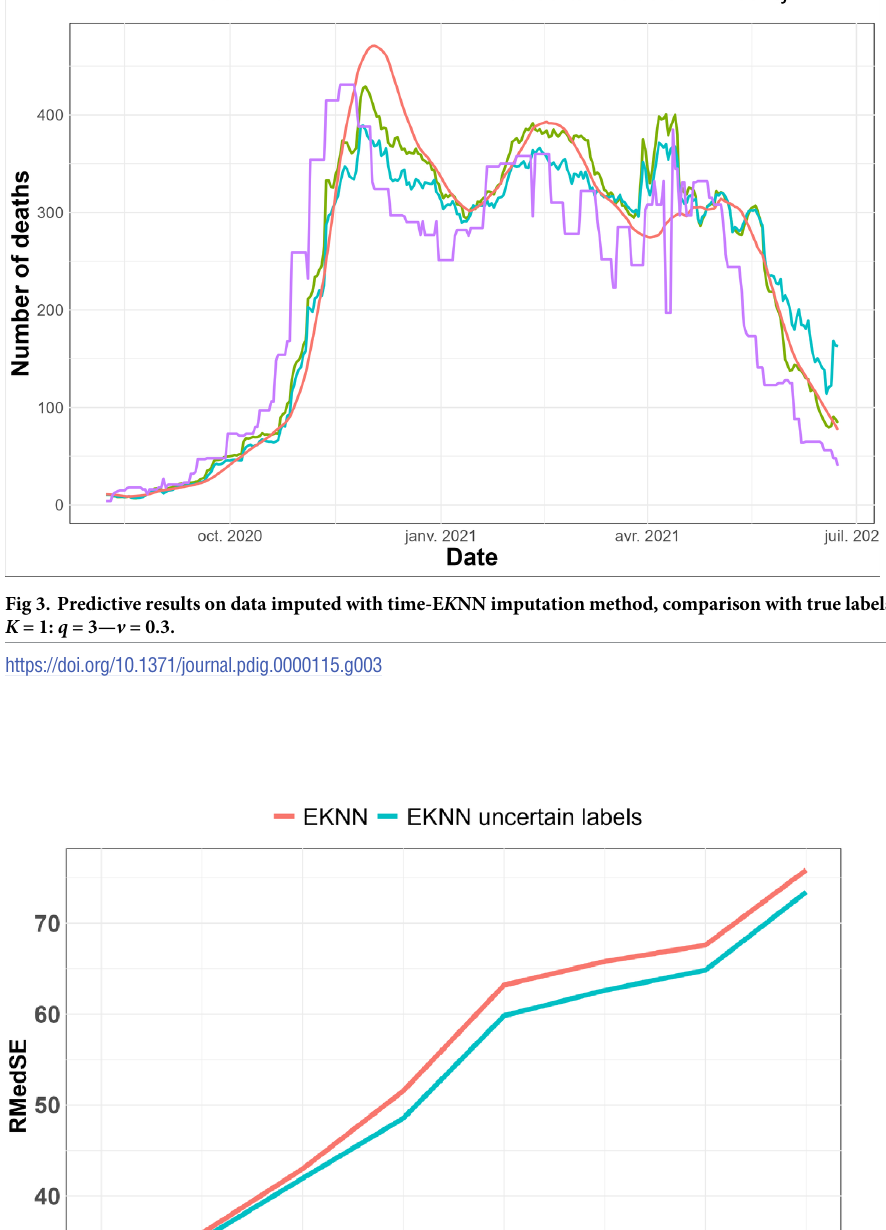
PLOS Digital Health | https://doi.org/10.1371/journal.pdig.0000115 October 25,